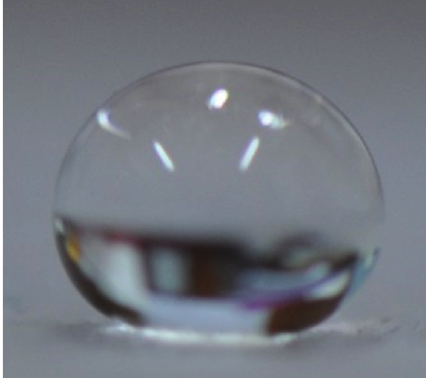
Figure 5: Image of water on the silica aerogel.